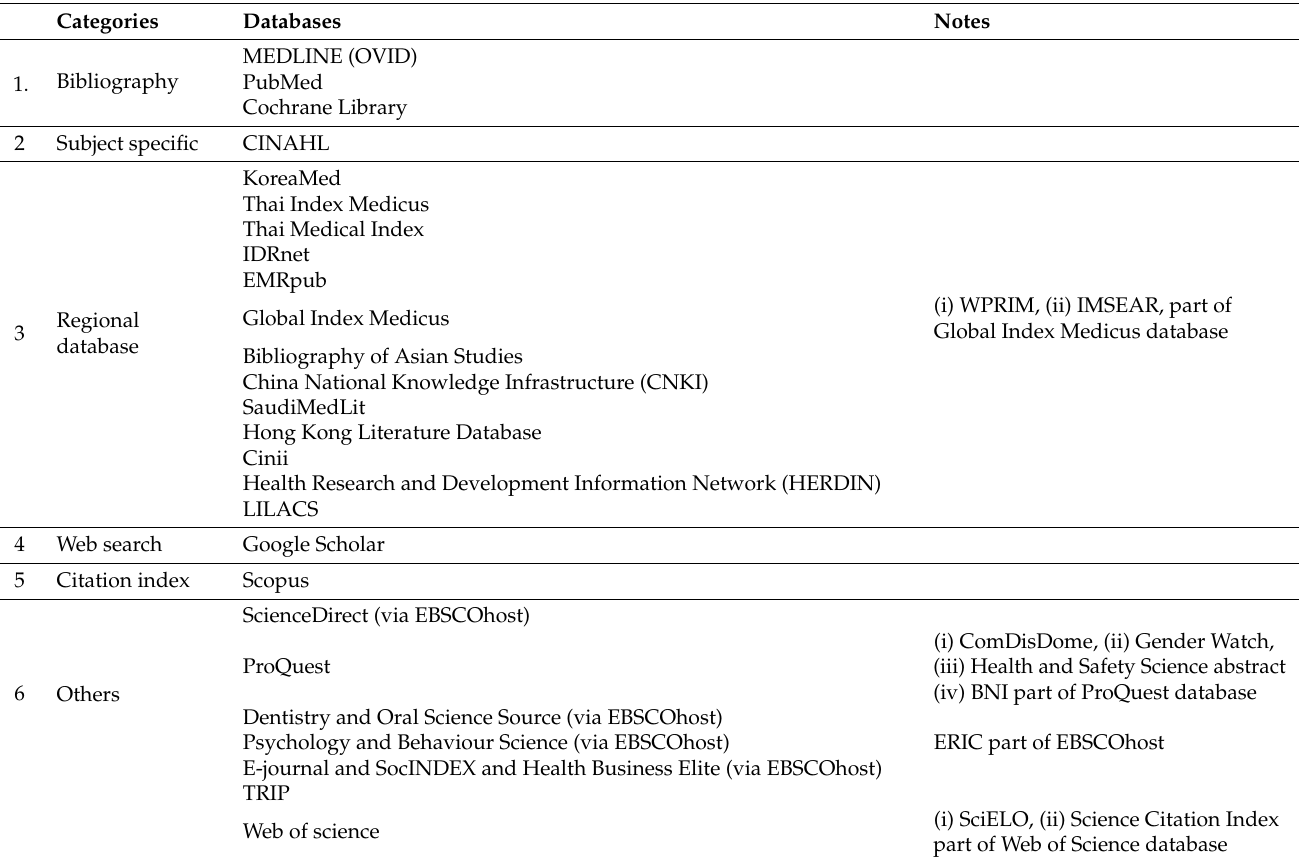
Table 6. Final list of 26 databases included in the proposed systematic review.